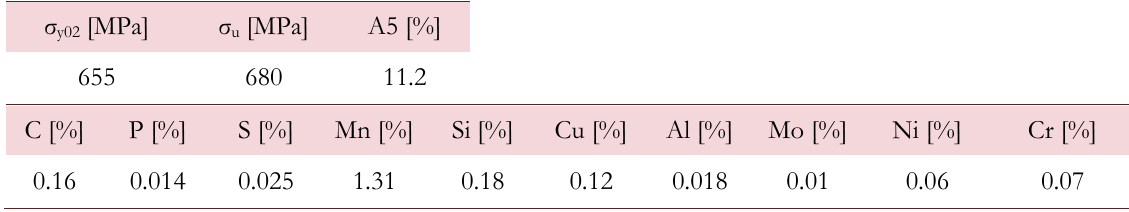
Table 1: Mechanical and chemical properties of S355J2+C